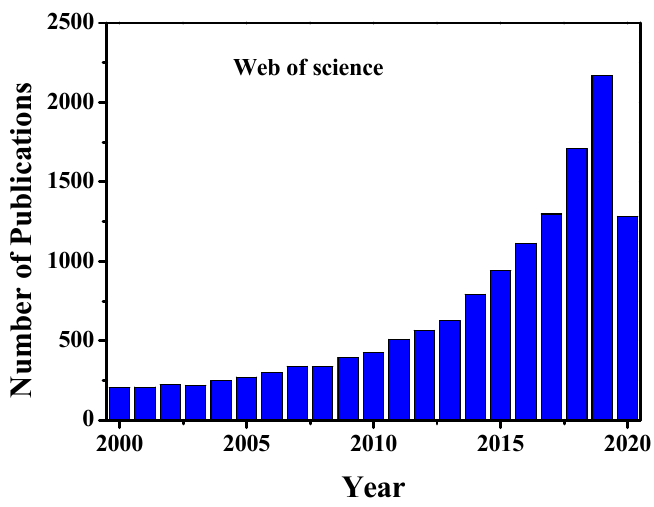
Figure 1. Year wise single-cell related publications. The data are adapted from web of science. Data until 25th August 2020.